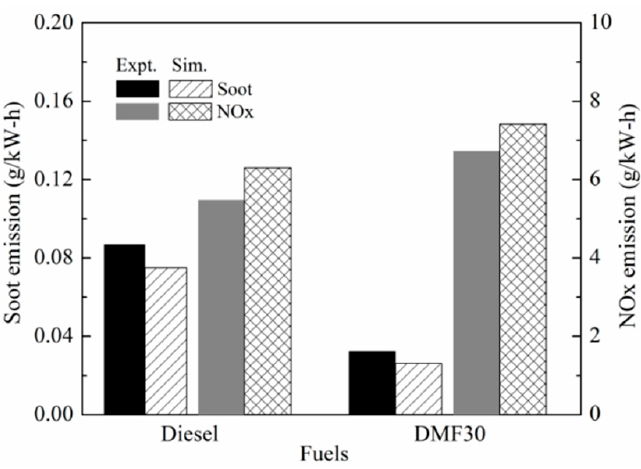
Figure 14. Measured and predicted soot and NOx emission pro fi les.